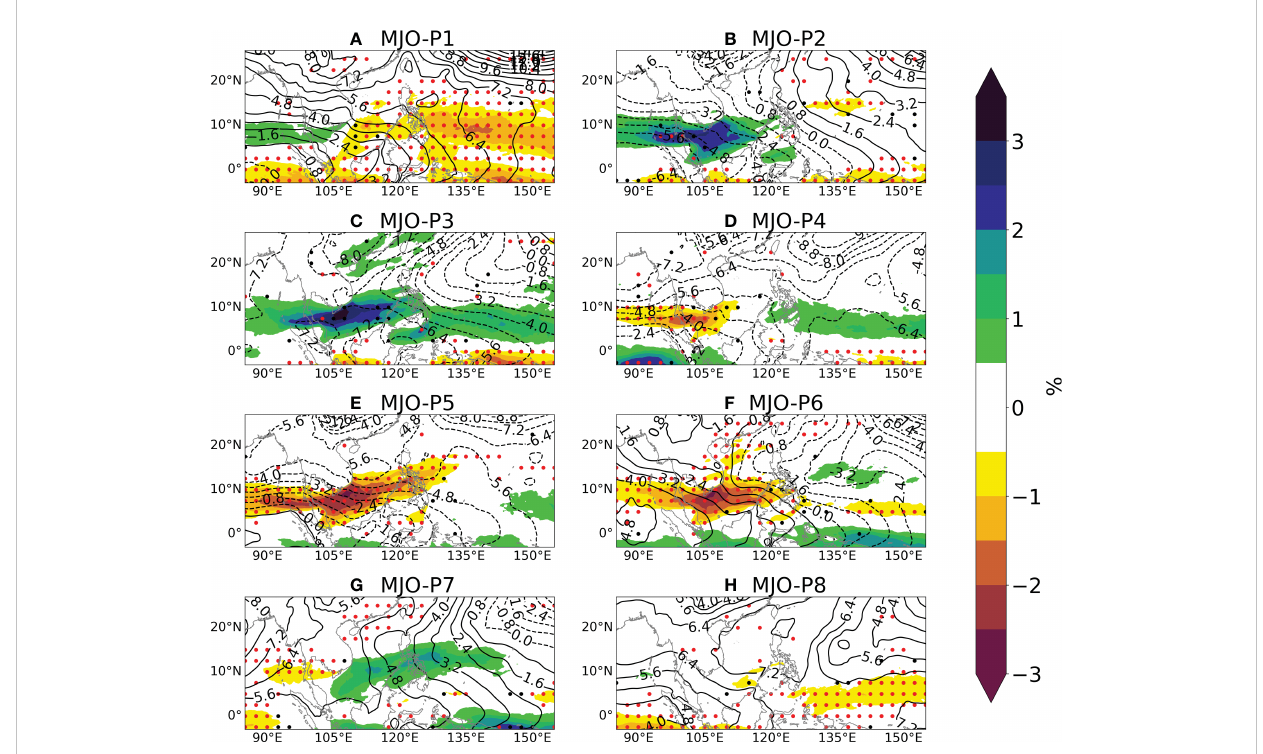
FIGURE 8 850-hPa geopotential height anomaly (contour, unit: gpm) and anomalous AR frequency (color, unit: %) based on eight phases of MJO. (A – H) corresponding to phases 1 to 8. Red (black) stippling indicates statistically signi fi cant trends with con fi dence levels above 95%